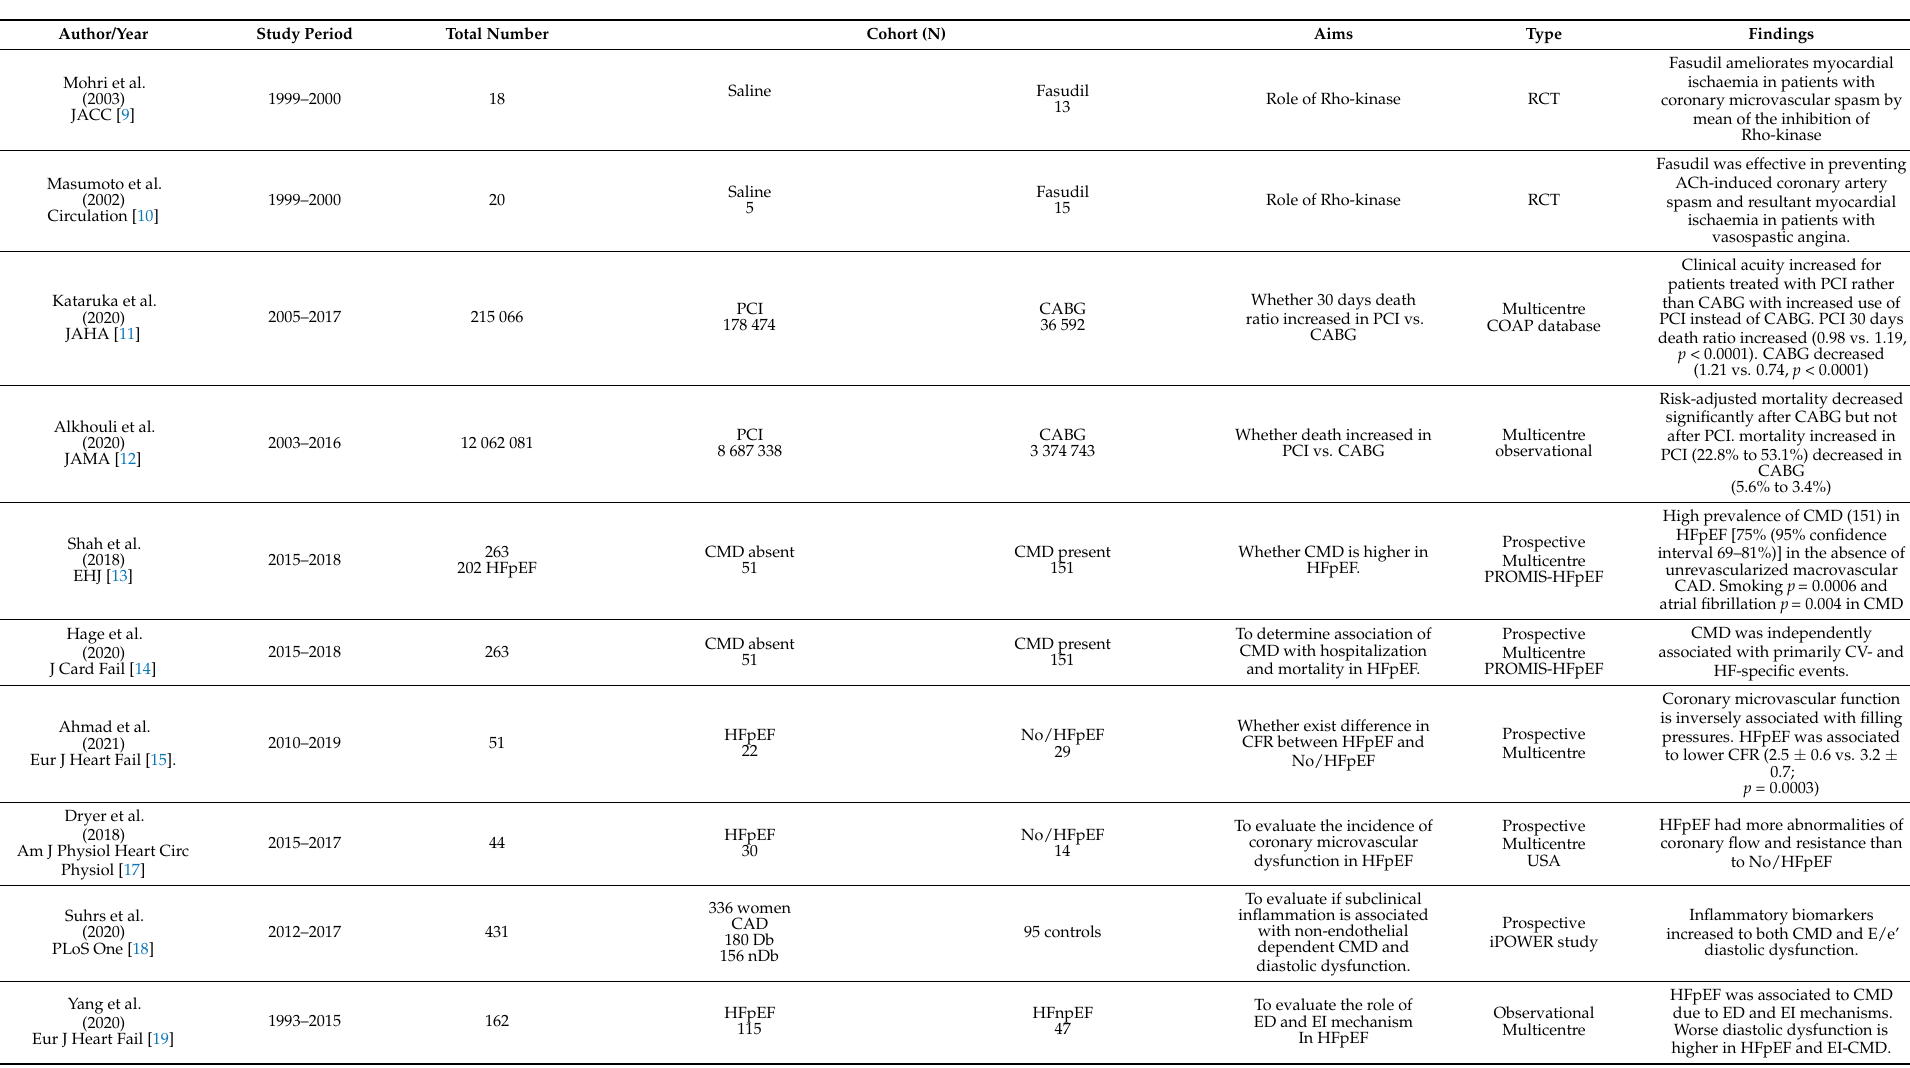
Table 1. Characteristics of the included